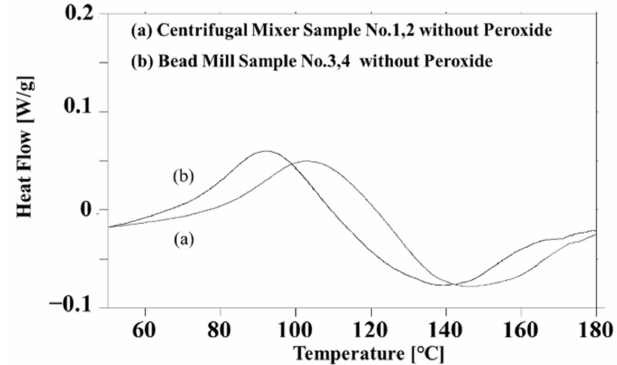
Figure 3. DSC data obtained from “Centrifugal mixer samples 1 and 2 without peroxide” and “Bead mill samples 3 and 4 without peroxide.